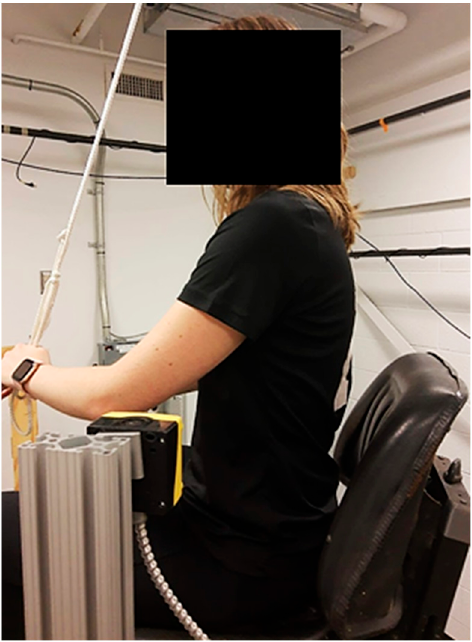
Figure 2. Participant seated on the tractor seat in the hexapod robot setup.